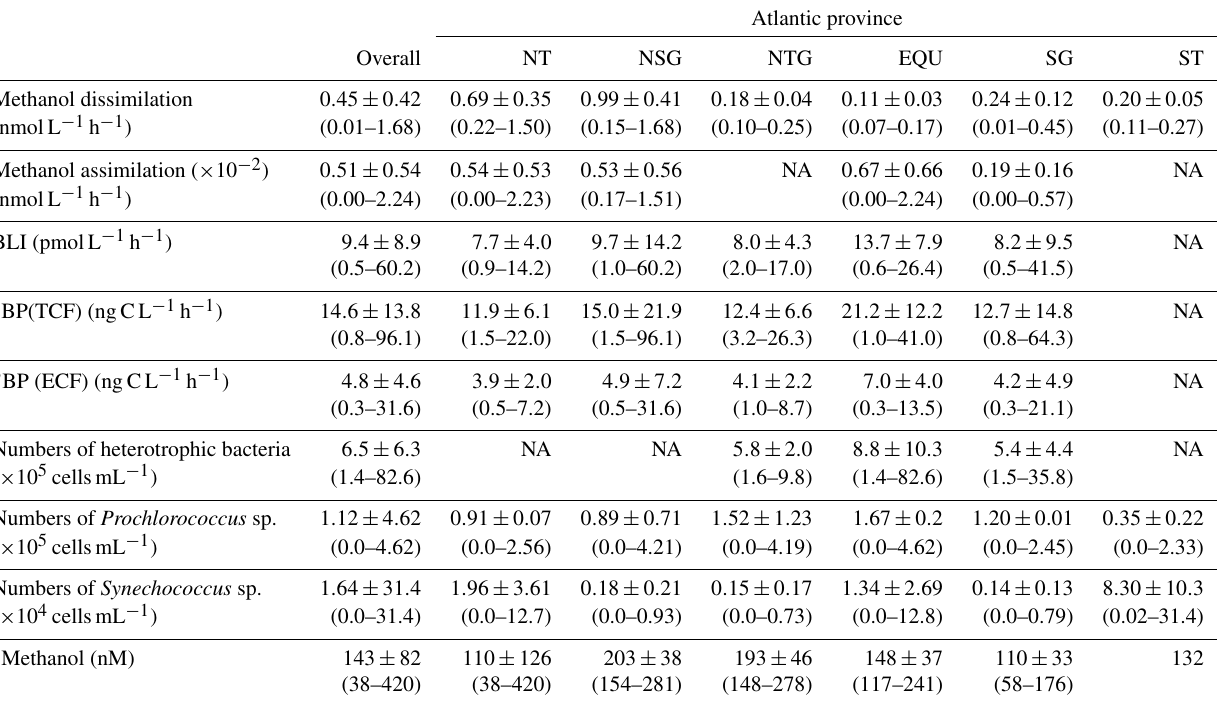
Table 1. Summary of rates of methanol uptake (dissimilation and assimilation), methanol concentrations, bacterial leucine incorporation (BLI) and production (BP), numbers of heterotrophic bacteria (BN), Prochlorococcus (Pros) and Synechococcus (Syns). Values given are average ± standard deviation (range). NA denotes that data are not